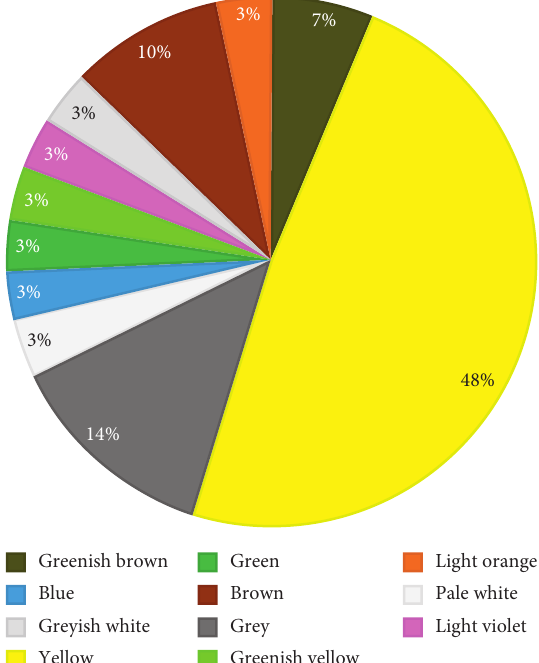
Figure 2: Types of pigment produced by isolates on starch casein agar.